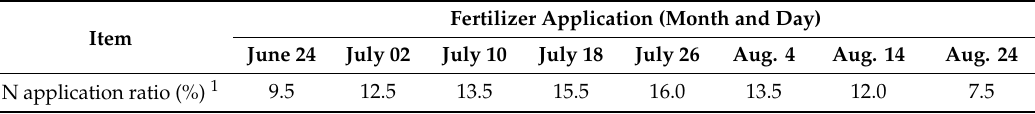
Figure 1. Location and layout of the cotton field experiment (N1: 0 kg N / ha; N2: 120 kg N / ha; N3: 240 kg N / ha; N4: 360 kg N / ha; and N5: 480 kg N / ha). Table 1. Amount of nitrogen (N) applied with date of application.